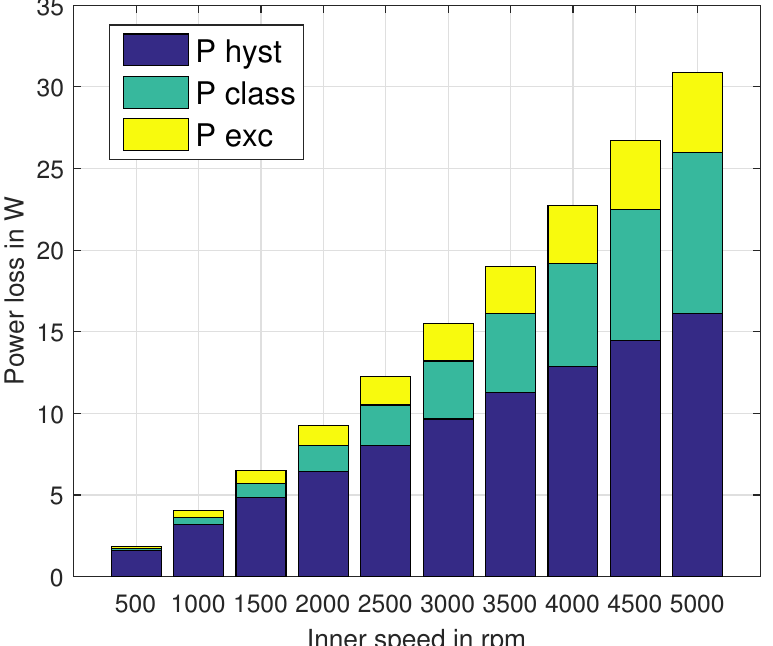
Figure 13. Outer iron yoke loss components. The losses are computed varying the rotors speed at the maximum torque capability.